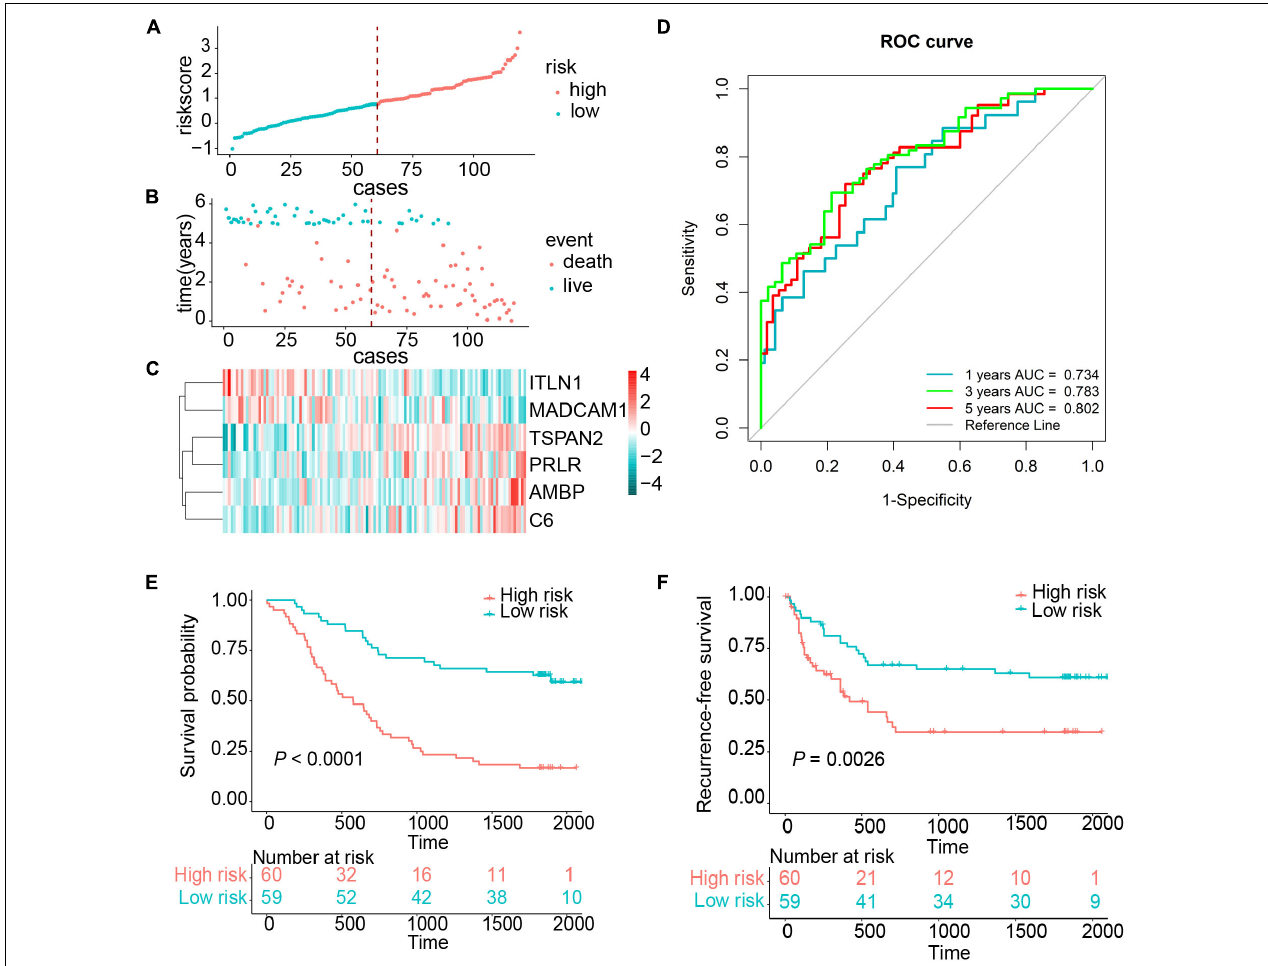
FIGURE 2 | Risk score distribution and survival of patients in the training cohort. (A) The risk scores for 119 patients of the training cohort (GSE53624). (B) The survival of each patient in the training cohort (GSE53624). (C) Expression distribution of the six genes in the training cohort, with red indicating higher expression and blue indicating lower expression. (D) ROC analysis of immune-related genes signature for prediction of survival at 1, 3, and 5 years in the training cohort. (E,F) Kaplan–Meier curves of OS and RFS in 119 patients of the training cohort based on risk score,